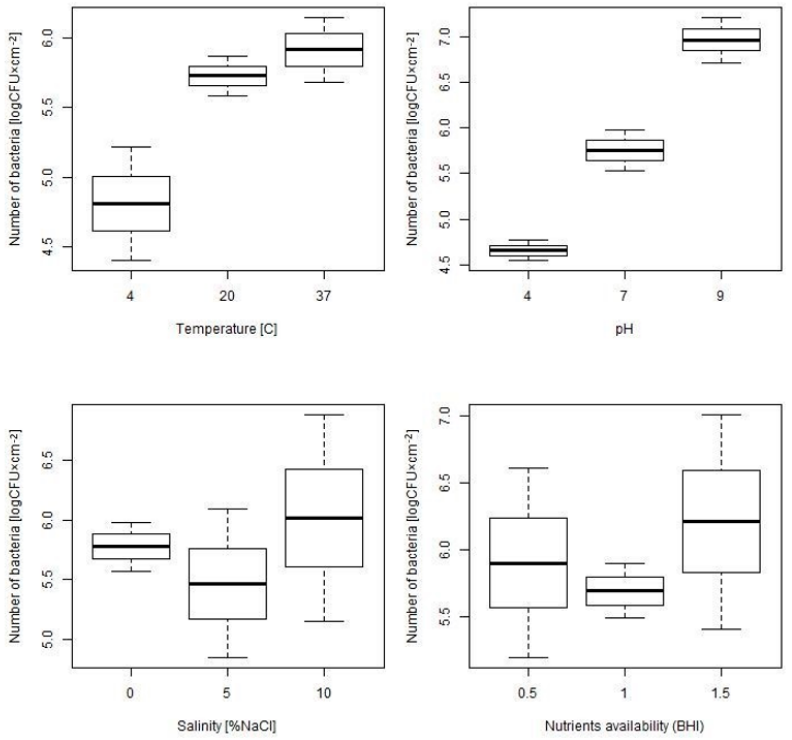
Figure 1. The distribution of the number of bacteria recovered from biofilm formed under various environmental conditions—the boxplots show mean with SE (Standard error) and 95% confidence interval.